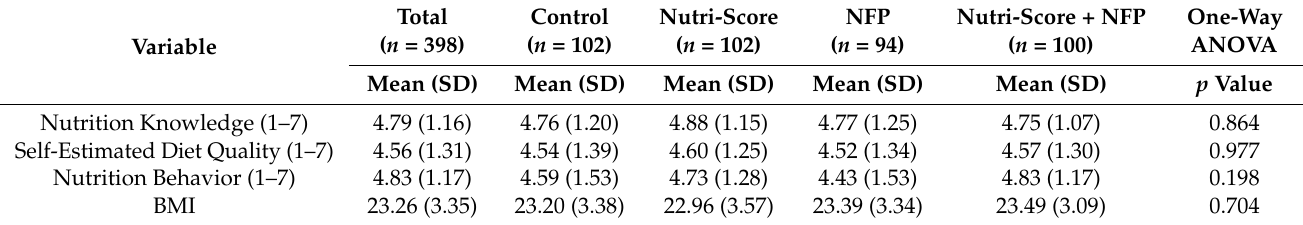
Table 3. Food knowledge, food behavior, and BMI in the general sample (N =